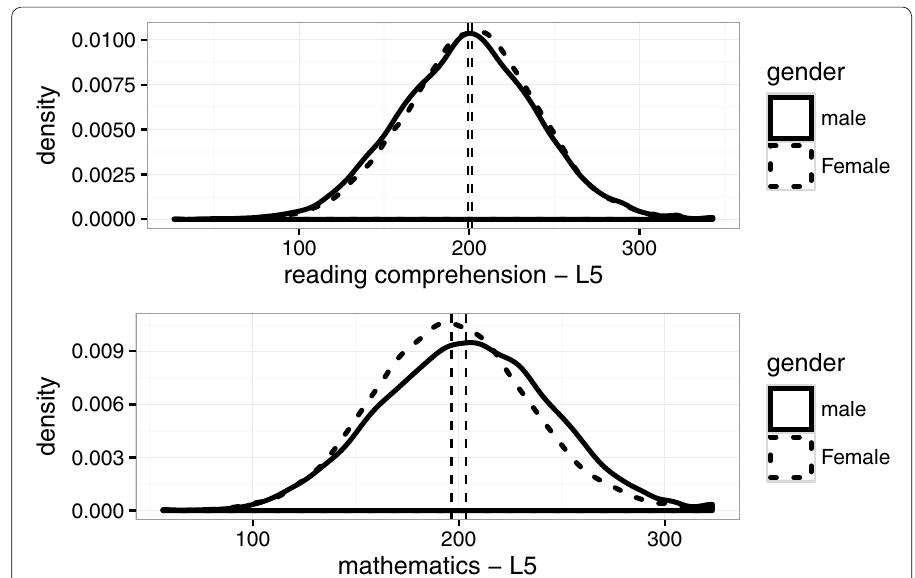
Fig. 4 Reading comprehension and mathematics achievement in for fifth-graders by gender. The vertical dotted lines represent the group averages